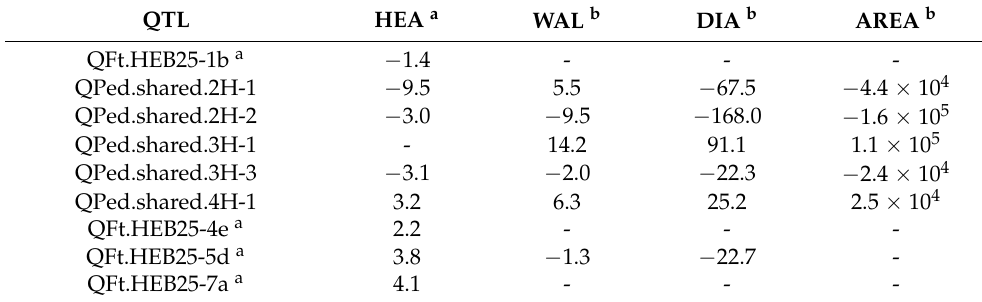
Table 5. Effect comparison of heading (HEA) QTL and corresponding peduncle QTL regions. QTL HEA a WAL b DIA b AREA